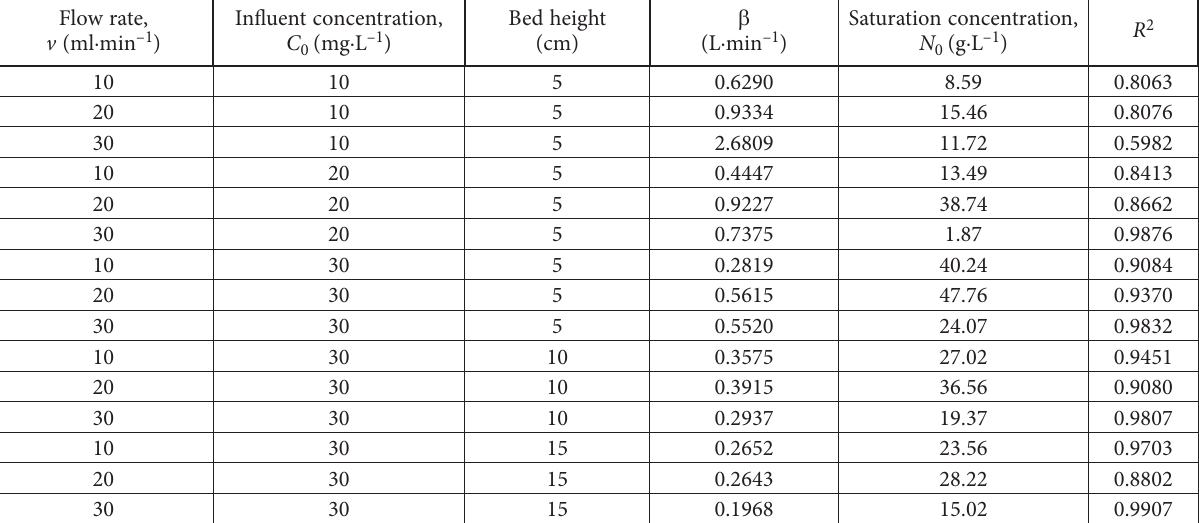
Table 4. Wolborska model parameters using linear regression analysis